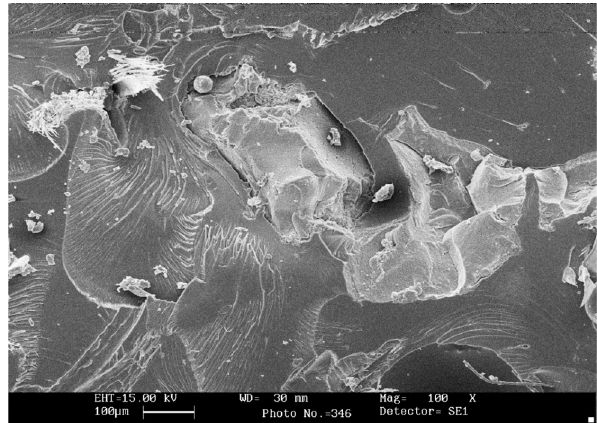
Figure 10: Scanning electron micrograph of 2.5% CR with 5.0% CFF